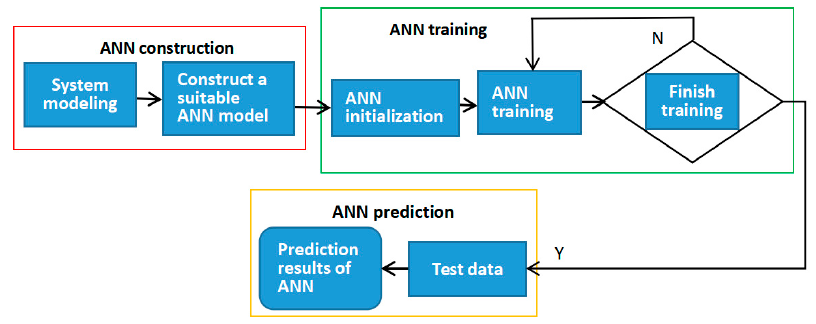
Figure 2. The artificial neural network algorithm flow chart. Table 3. Statistical criteria of the input parameters and performance attributes (output parameters) used in the ANN model.